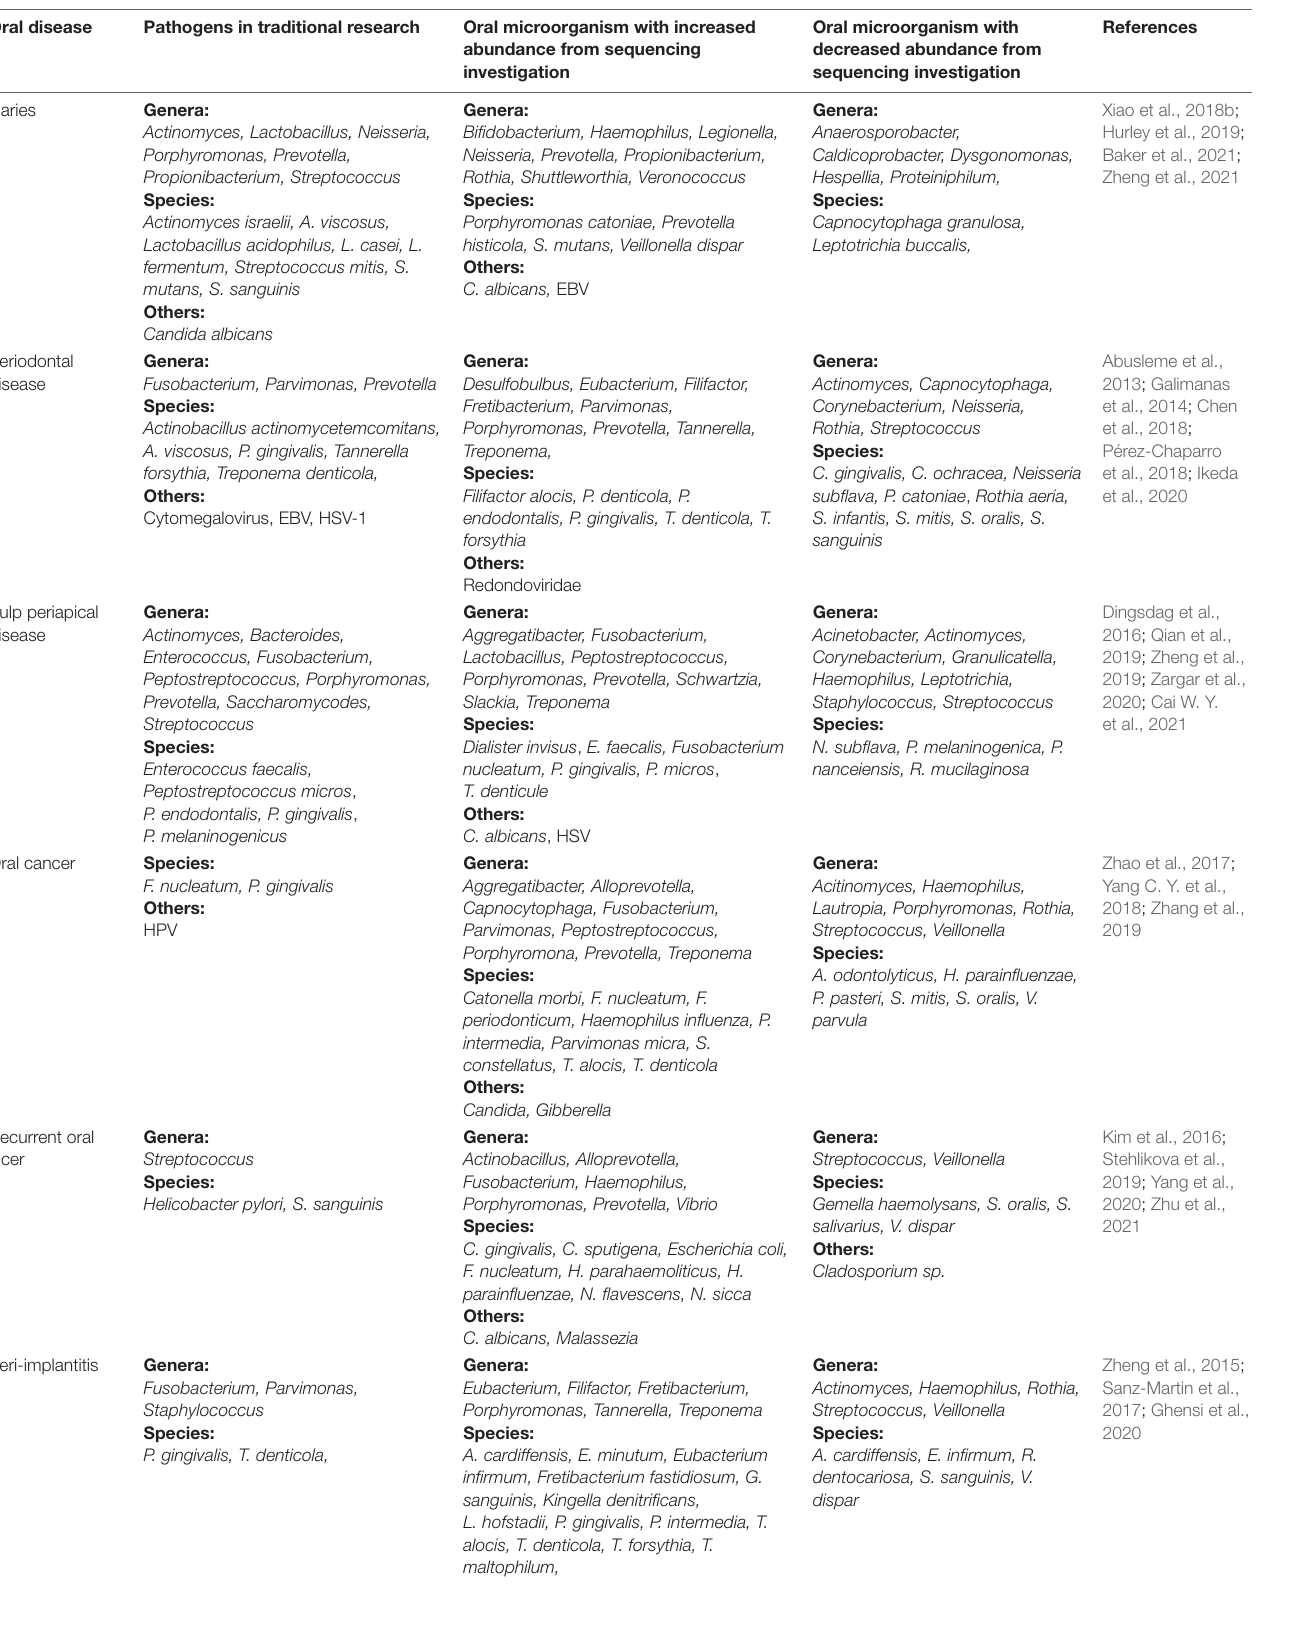
TABLE 1 | Oral microorganisms with varying abundances in different oral